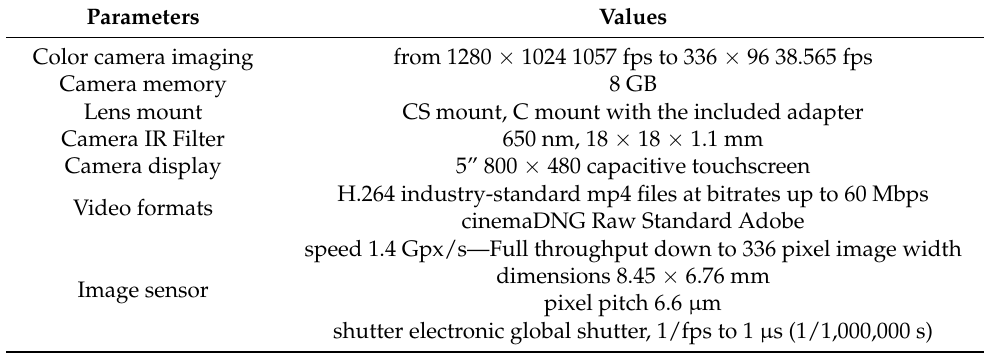
Table 4. Parameters of a Chronos 1.4 high-speed camera (Adapted form [33]). Reproduced from 33], Krontech: